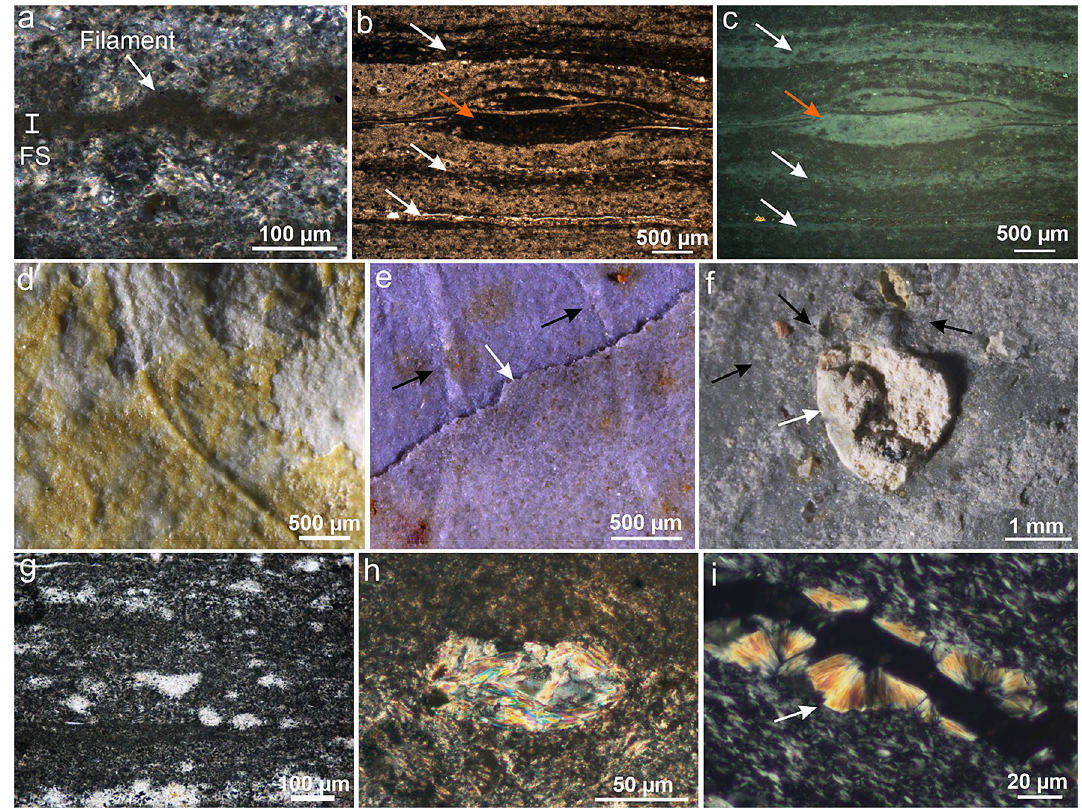
Figure 2. Pyroclasts from the fossiliferous horizons of the Itajaí Basin. ( a ) Vertical thin section through micron-sized filament. Note the concentration of authigenic clays on the fossiliferous surface (FS). Vertical thin section under transmitted ( b ) and reflected light ( c ) showing fossiliferous laminae (white arrows) and tuft (orange arrow) composed of authigenic clay minerals. ( d , e ) Micron-sized filaments covered by a layer of altered ash. ( f ) Accretionary pellet (white arrow) and scattered phenocrysts (black arrows). ( g ) Pyroclasts devitrified to microcrystalline quartz. ( h ) Angular clast devitrified to sericite. ( i ) Fibrous radial sericite in early-formed fractures. Note the molding relationship (arrow) with the host rock. Image created using Inkscape 1.0 (https :// inksc